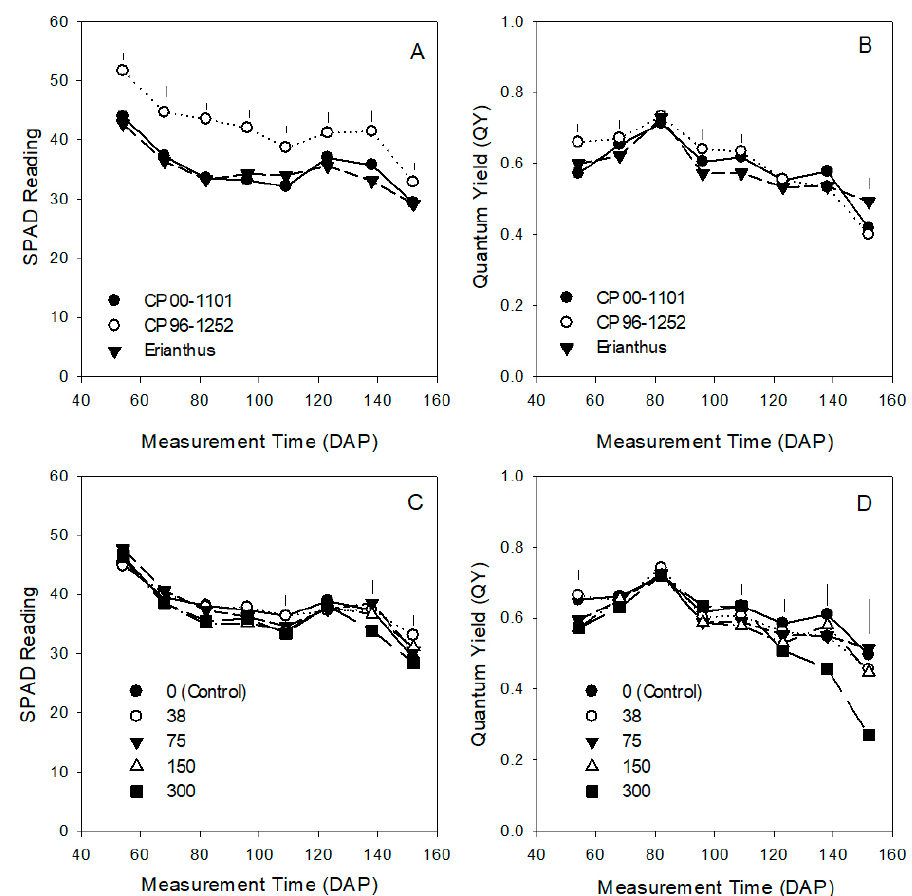
Figure 3. Leaf relative chlorophyll level (SPAD readings) and chlorophyll fluorescence parameter quantum yield (QY) of two sugarcane cultivars (CP 00-1101, CP 96-1252) and an Erianthus as affected by salinity treatments [0 (Control), 38, 75, 150, and 300 mM of NaCl added]. Vertical Bars indicate LSD 0.05 values if the main effects of ( A , B ) genotype or ( C , D ) salinity treatment are significant ( p ≤ 0.05) at a specific measurement time.